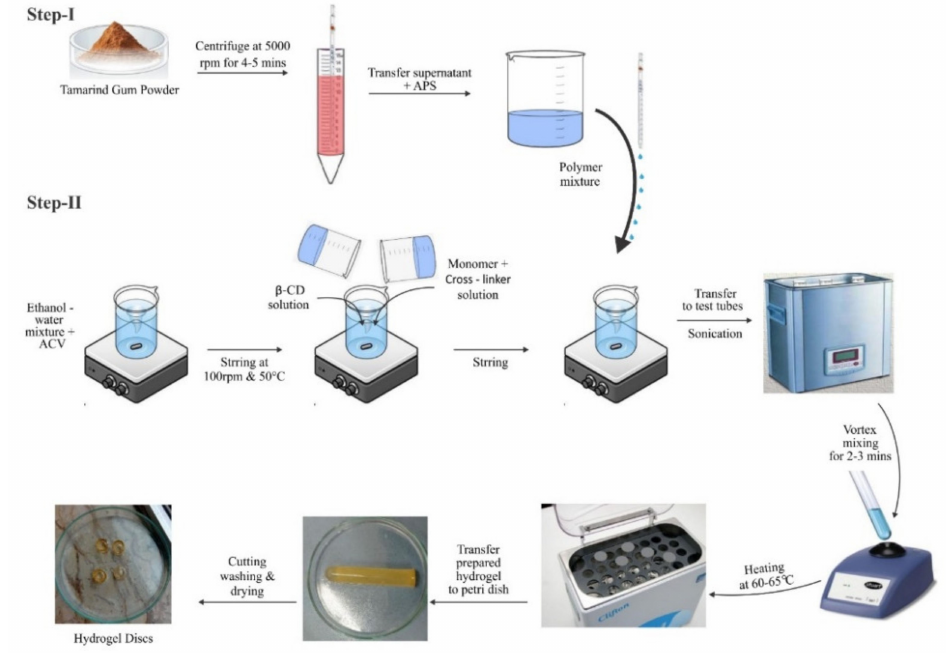
Figure 13. Schematic representation for the development of tamarind- β -CD-co-poly (methacrylate)